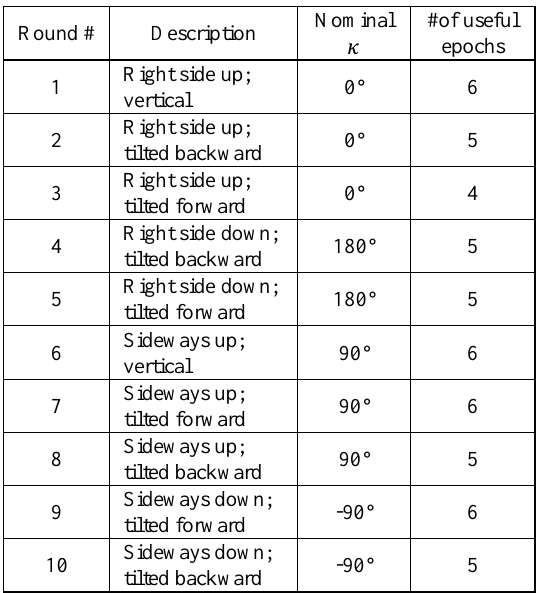
Table 1. Description of the target field orientation for the ten rounds of data